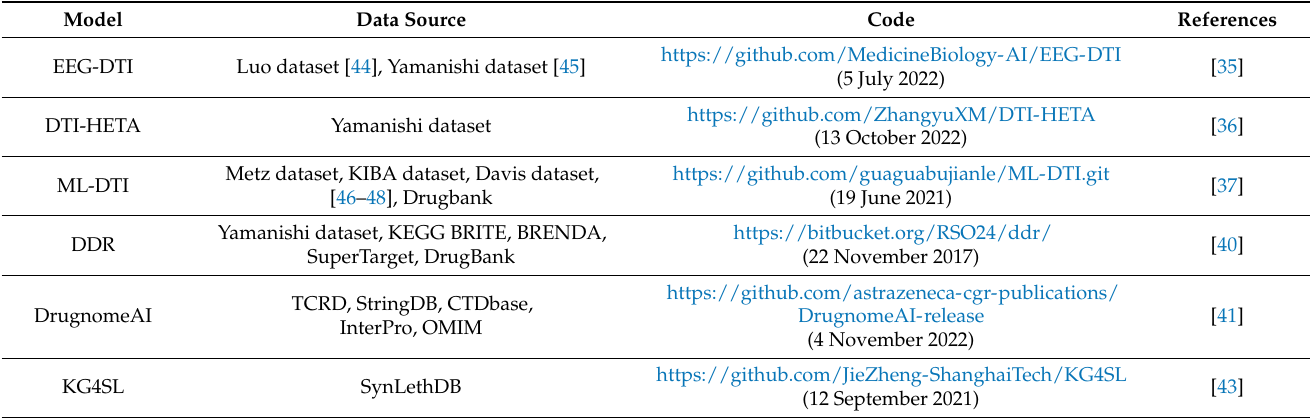
Table 2. Methods for anti-cancer drug target identification based on artificial